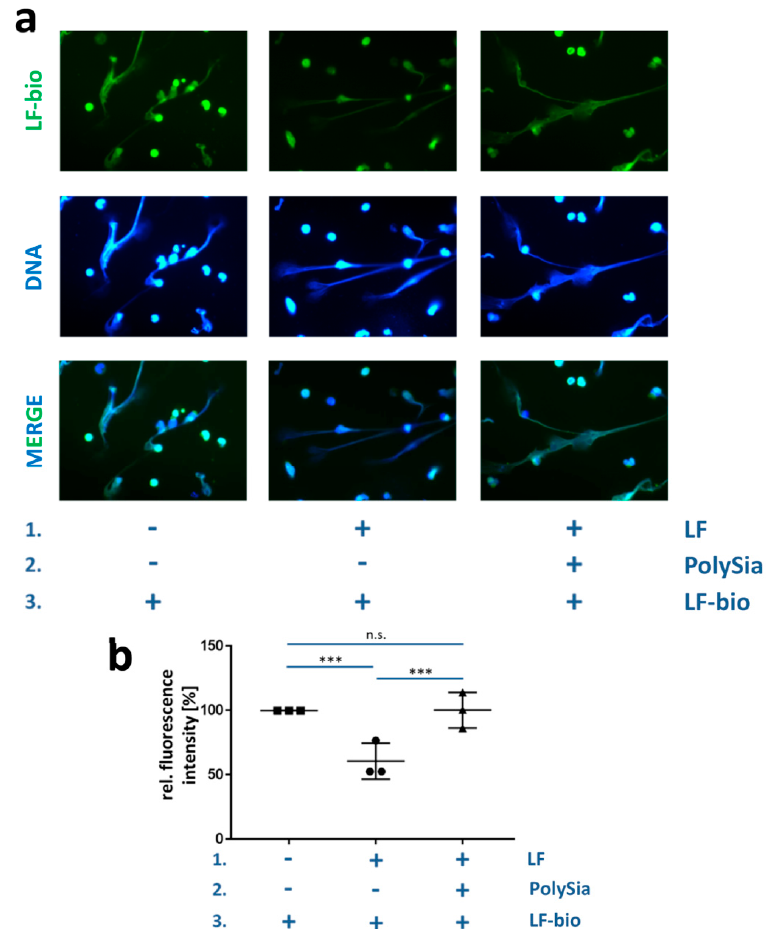
Figure 6. PolySia modulates the integration of lactoferrin into NETs. ( a ) After the formation of the NET fibers by induced bovine neutrophils, the fibers were treated in three successive steps: (1) Unbiotinylated lactoferrin, (2) polySia, and (3) lactoferrin-biotin. Three different combinations were applied. DAPI (blue) was used to stain the DNA, and lactoferrin-biotin (green) was visualized with an antibody against biotin. The scale bar represents 100 µm. ( b ) Quantification of lactoferrin-staining. The values for lactoferrin-biotin alone were set to 100%. Note: n.s. denotes not significant, * p < 0.05, ** p < 0.01, and *** p < 0.001.